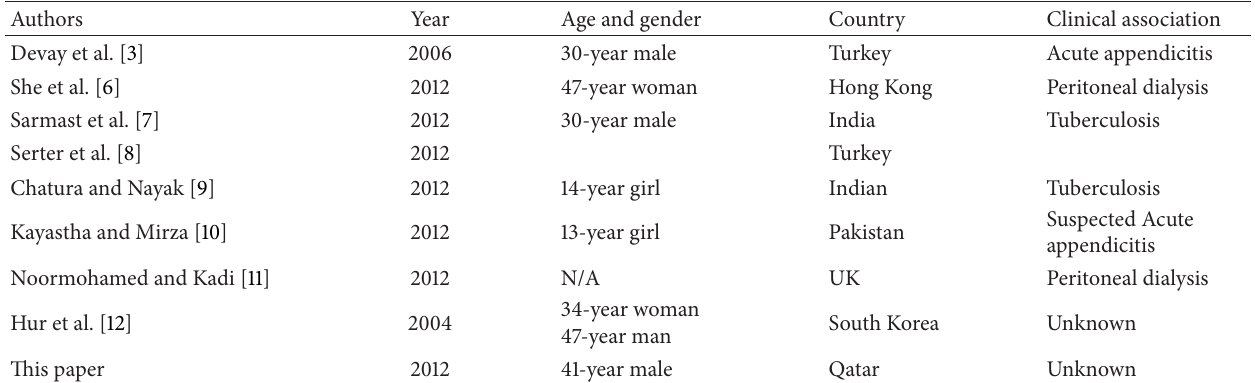
Table 1: Review of the literature for abdominal